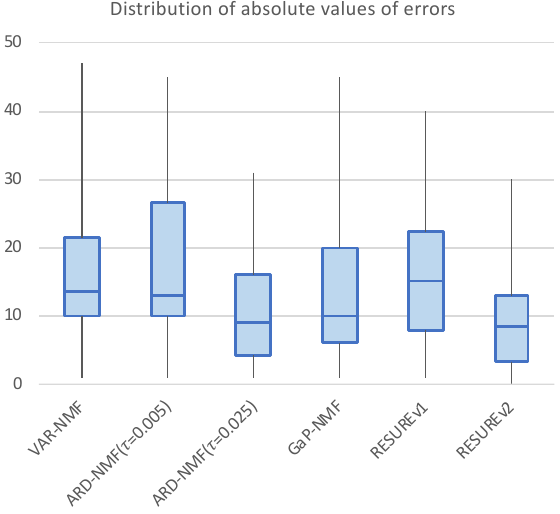
Figure 9. Distribution of absolute values of the estimation errors based on the number of notes. The top and bottom of the box indicate the third and first quartiles, and the horizontal bar within the box indicates the median value. The ends of the vertical bar indicate the maximum and minimum